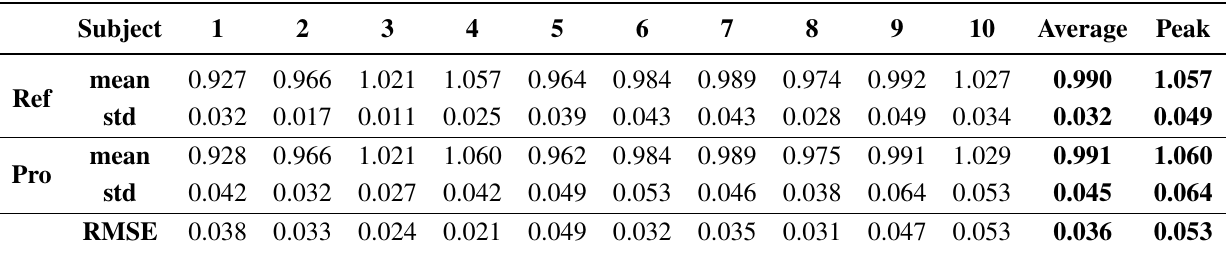
Table 4. Mean and standard deviation (in meters per second) of the reference (Ref) and proposed (Pro) systems and RMSE in detecting stride velocity for each subject. Averaged values across the ten subjects are also